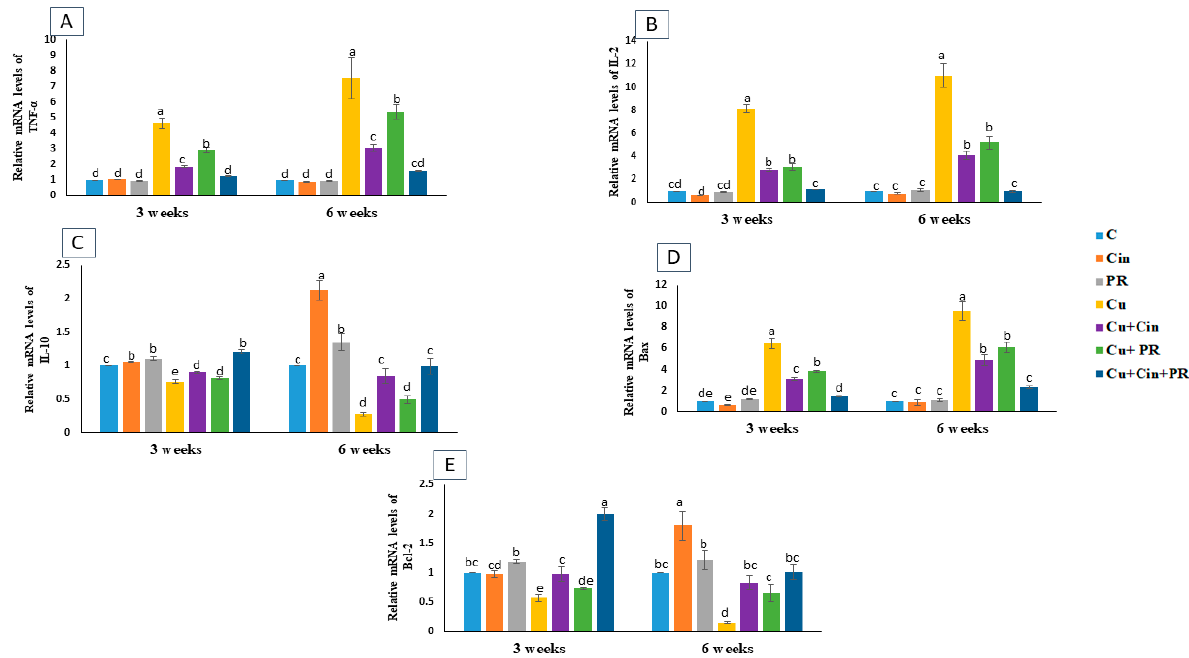
Figure 4. Relative mRNA expression of tumor necrosis factor alpha (TNF- α ) ( A ), interleukin (IL)-2( B ), IL-10 ( C ), Bax ( D ), and Bcl-2 ( E ) in renal tissues of chickens in response to administration of cinnamon (200 mg/kg diet), probiotic (1 g/4 L drinking water), and CuSO 4 (300 mg/kg diet) either individually or concurrently for 3 weeks or 6 weeks. Data are exhibited as mean ± SEM ( n = 5 chickens). Each bar carrying different letters is significantly different ( p < 0.05). C, control; Cin, cinnamon extract; PR, probiotic; Cu, copper.